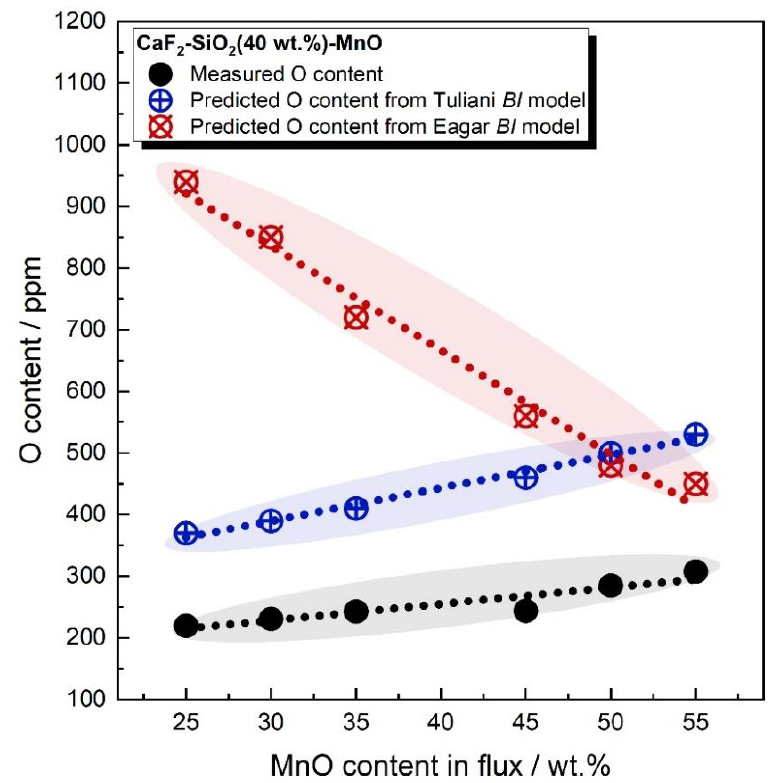
Figure 6. WM O content as a function MnO content in flux.